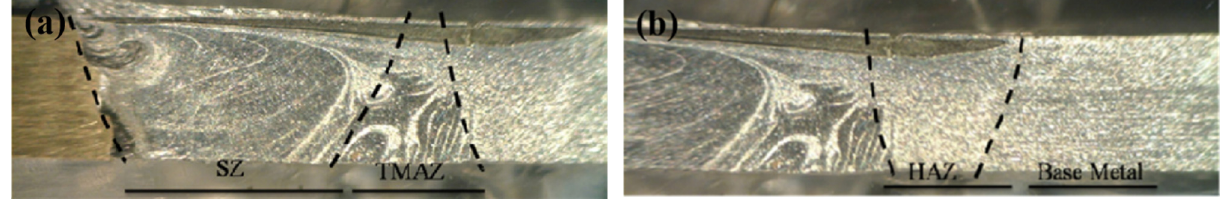
Figure 13. Macroscopic morphology of the Cu–Al FSW butt joint ( a ) SZ and TMAZ; ( b ) HAZ and base metal (adapted from [42], with permission from Elsevier, 2011).